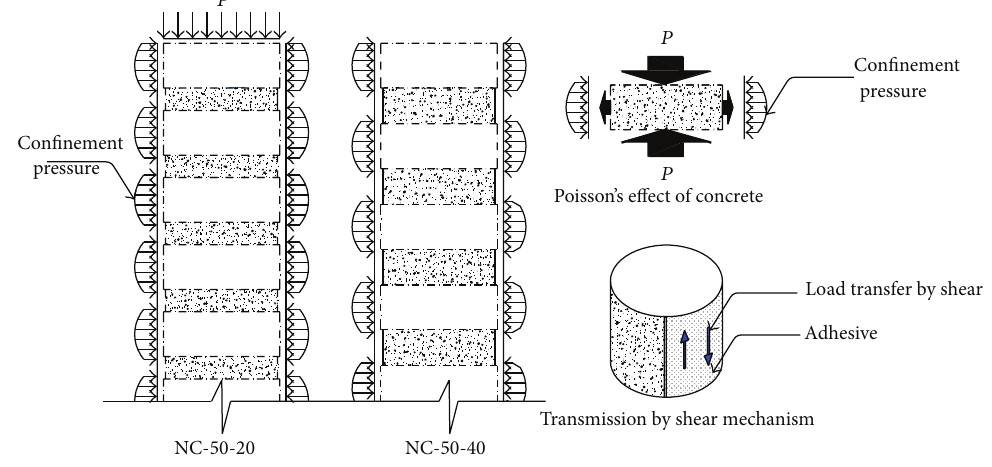
Figure 7: Confinement provided by CFRP strips and transmission by shear mechanism.